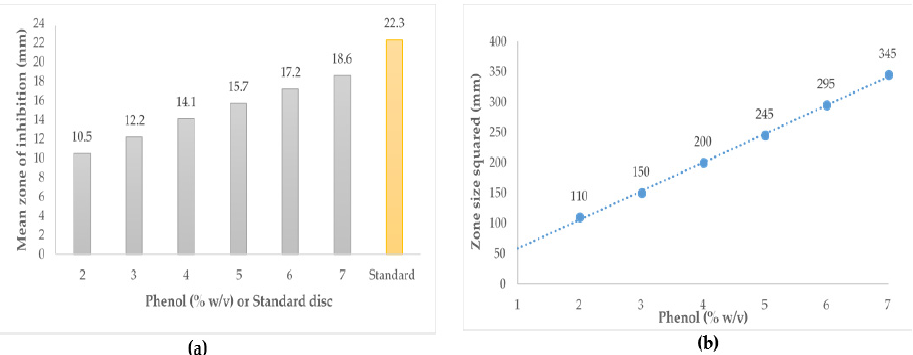
Figure 7. Schematic representation of ( a ) zone sizes for phenol standards and antibiotic disc ( b ) phenol standard curve.